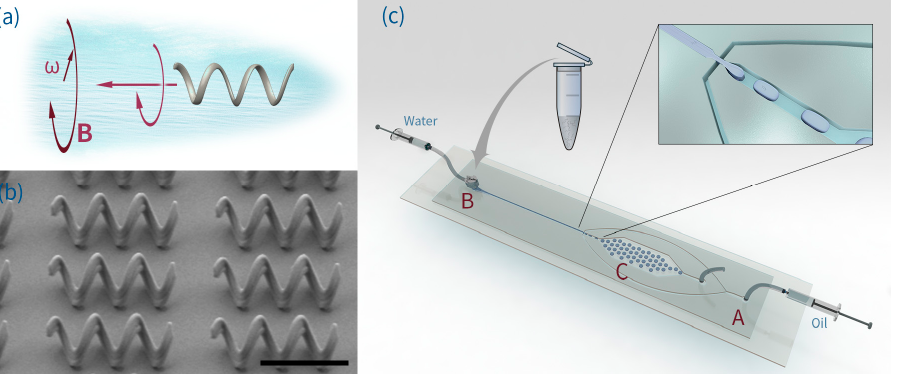
Figure 1. ( a ) Illustration of a helical ABF propelled by a rotating weak magnetic field B; ( b ) SEM image of a printed (and uncoated) MS array on a glass substrate (scale bar is 10 µm); ( c ) Schematic of the PDMS microdevice that contains a flow focusing structure for encapsulating ABFs in droplets. Port A serves as the oil inlet and port B is coupled to a chip-to-world connector, from which the aqueous suspension of ABFs is introduced.